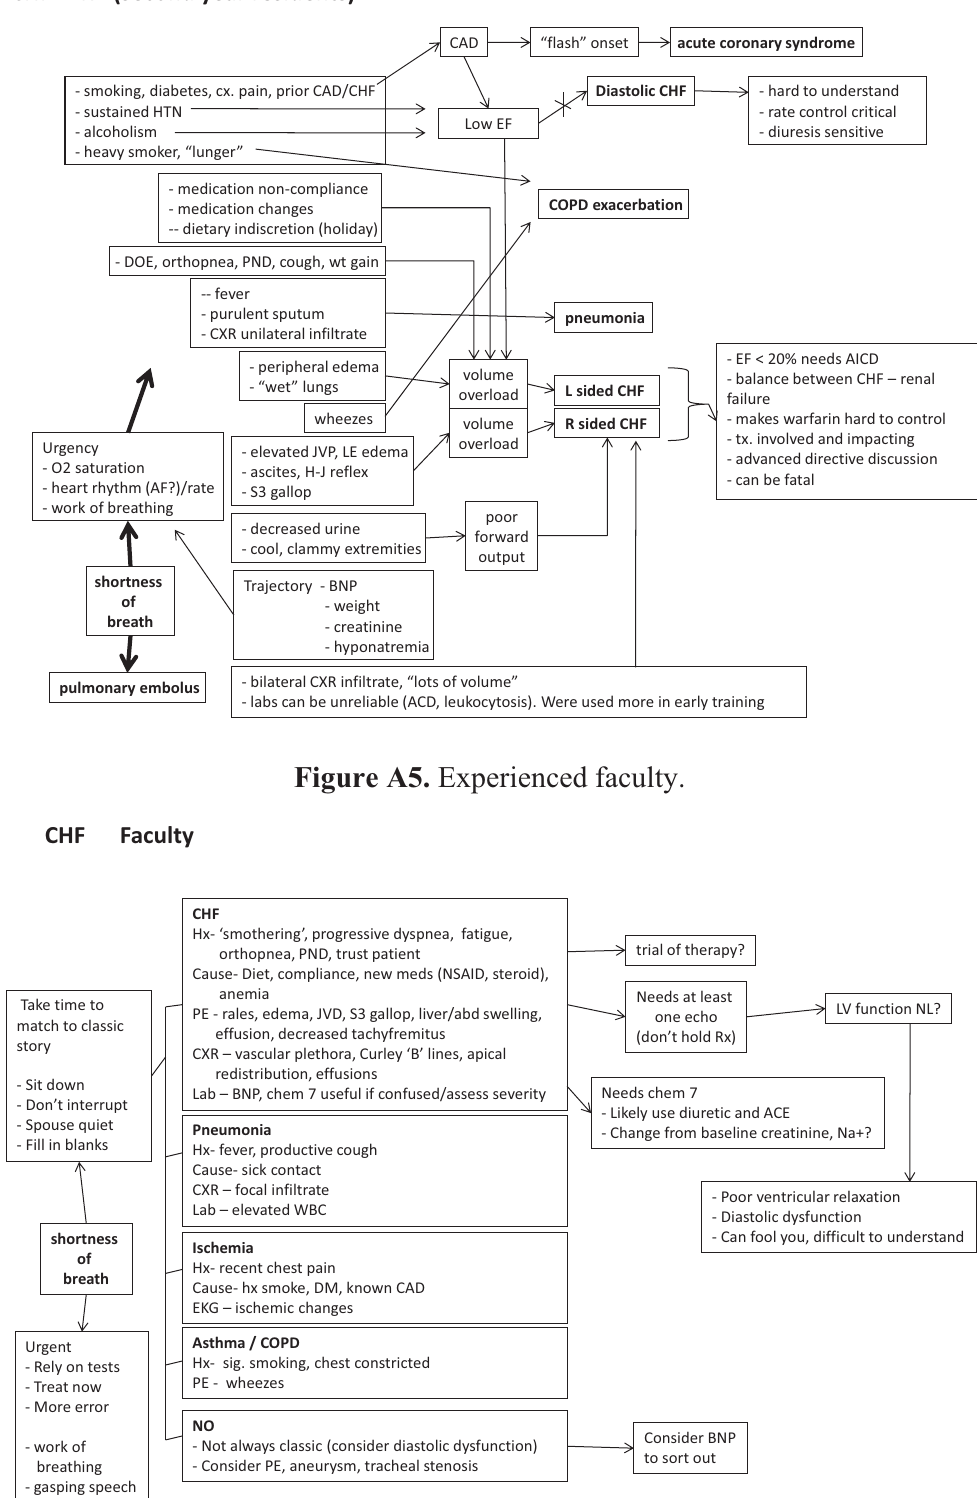
Figure A4. Second year medicine residents.